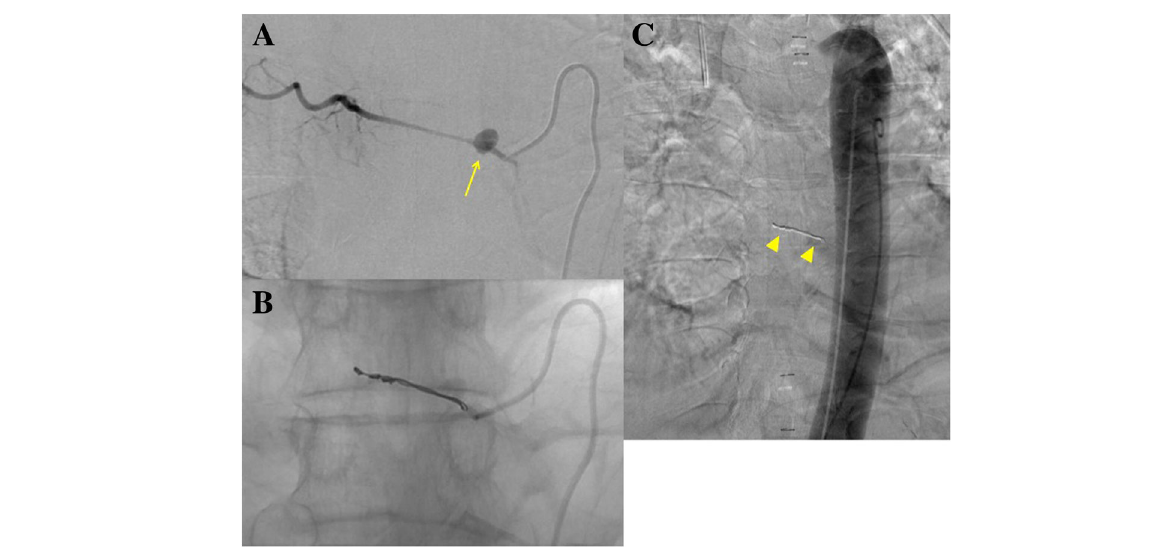
Fig. 5 a A pseudoaneurysm of the right seventh intercostal artery ( arrow ) was confirmed by digital subtraction angiography at the same location as on enhanced computed tomography. b After embolization. c Aortography revealed the positional relationship between the